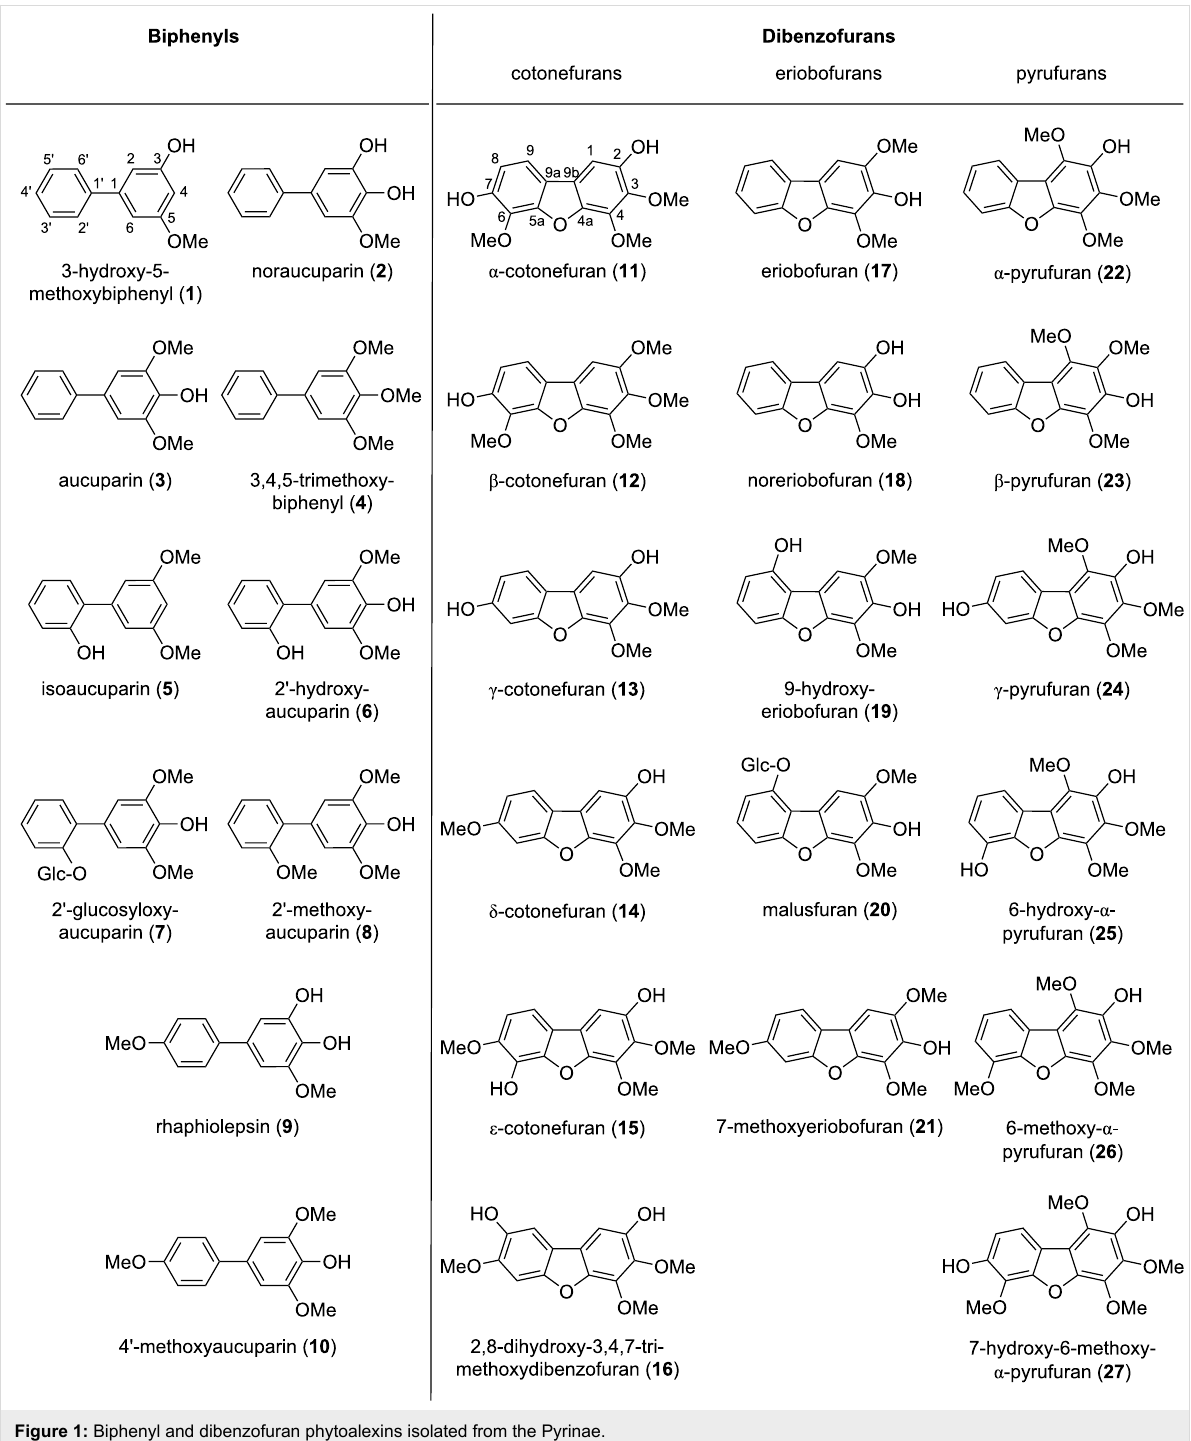
formed antimicrobial compounds [2]. To date, 10 biphenyls and 17 dibenzofurans have been detected in 14 genera of the Pyrinae (Figure 1) [3-23]. The majority of these inducible defense compounds were found as a result of fungal attack.